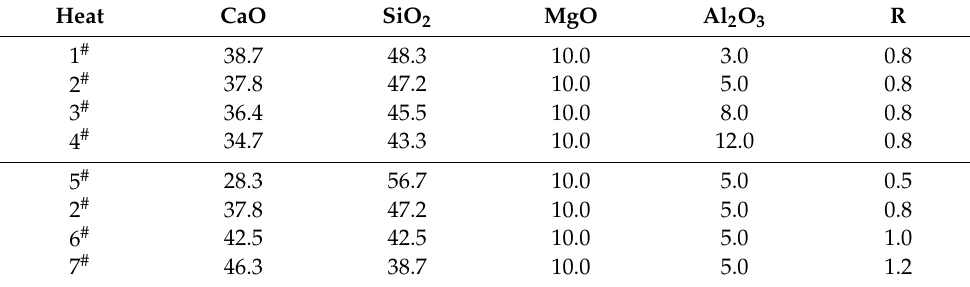
Table 2. Chemical compositions of the low-basicity refining slag